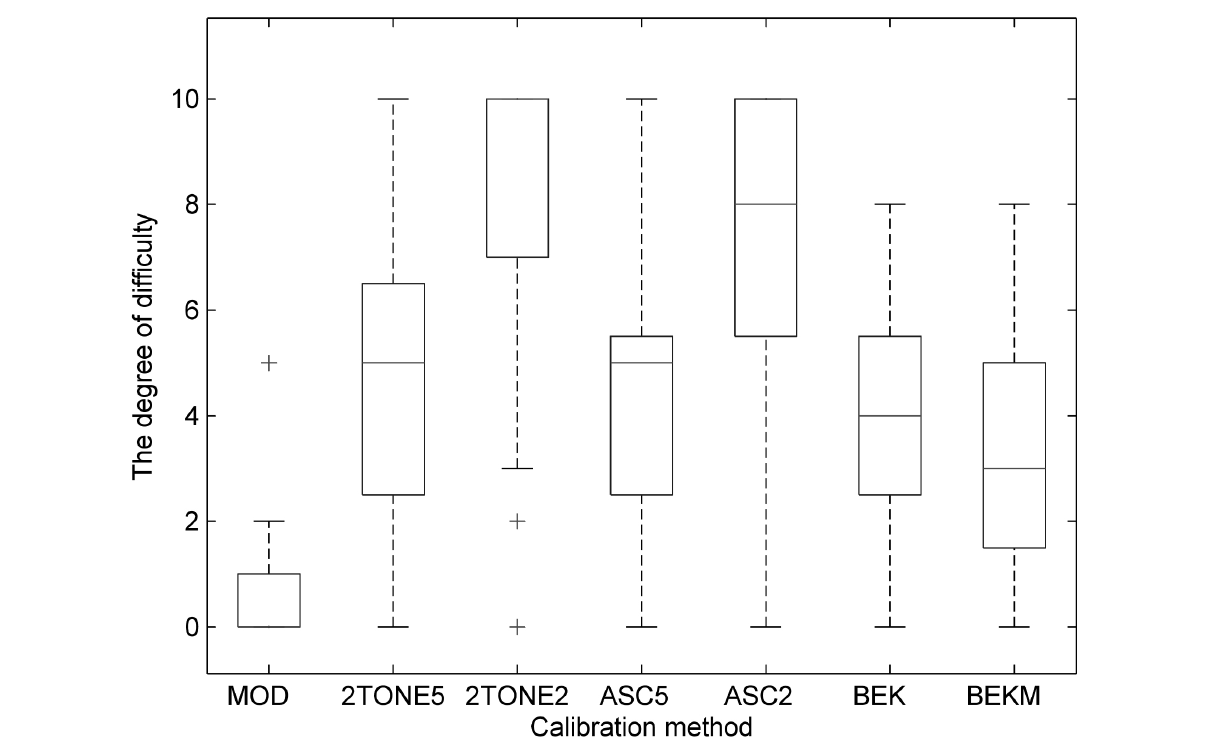
Figure 2. Difficulty ratings of the calibration methods evaluated by 25 participants (0=easiest; 10=hardest). The horizontal line in each box represents the median, top and bottom box borders represent 75th and 25th percentiles, respectively; crosses represent outliers. MOD: modulated signal; 2TONE5: dual tone (5 dB); 2TONE2: dual tone (2 dB); ASC5: ascending (5-dB step); ACS2: ascending (2-dB step); BEK: Bekesy (continual); BEKM: Bekesy